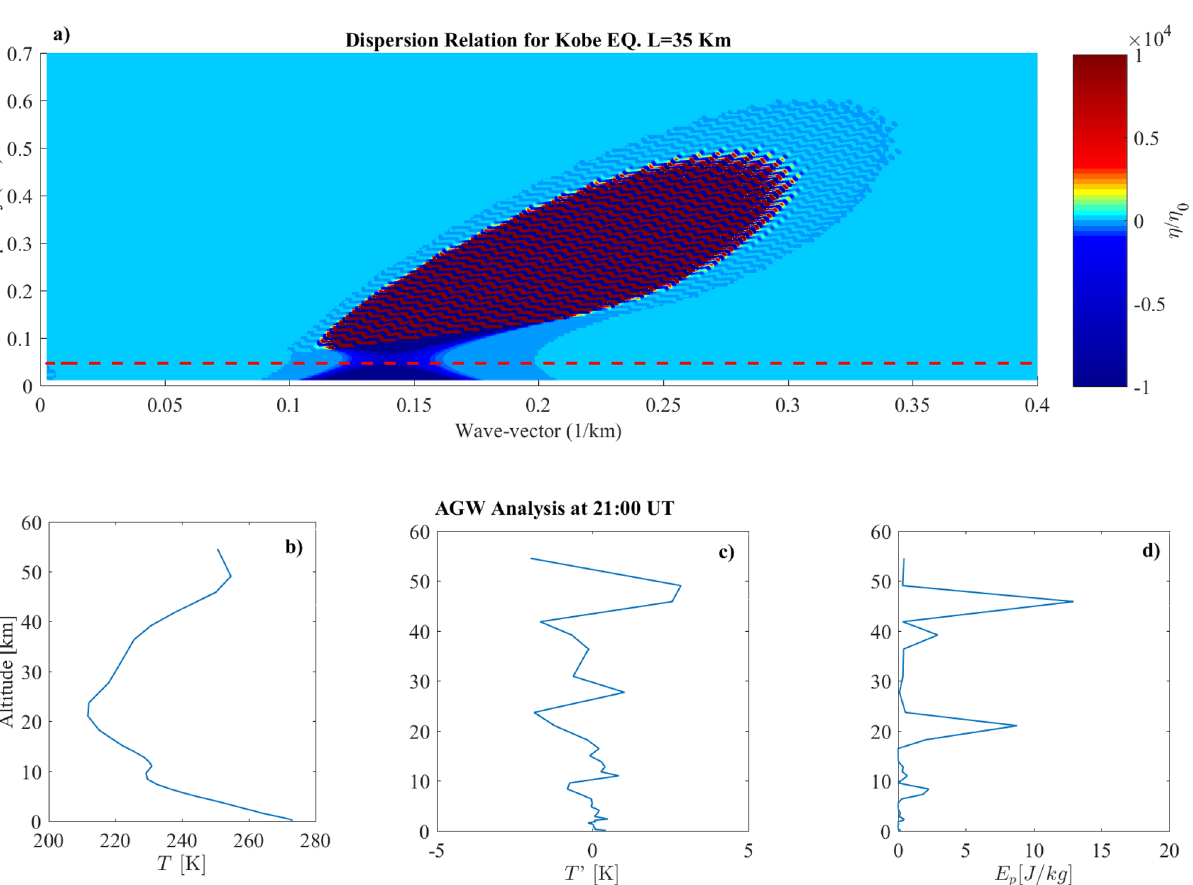
Figure 1. ( a ) Dispersion Relation evaluated for the Kobe Earthquake using the parameters in Table 1. The dashed line represents the parameter c 0 / 2 h . ( b ) Vertical Temperature profile over the EQ epicenter. ( c ) Fluctuations of the vertical temperature profile over the EQ epicenter. ( d ) Potential energy density vertical profile over the EQ